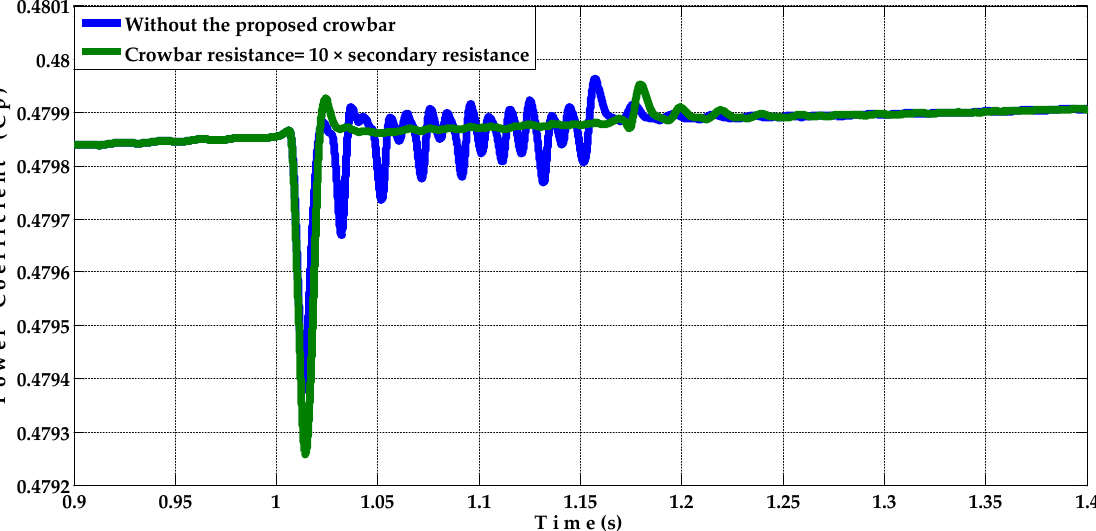
Figure 17. Power coefficient of wind turbine with and without the proposed crowbar under single-line to ground fault.